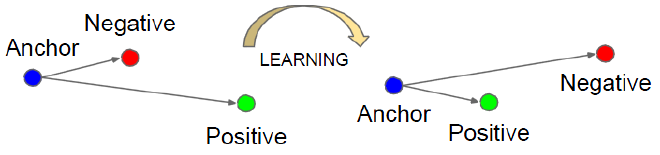
Figure 5. Function of the triplet loss.